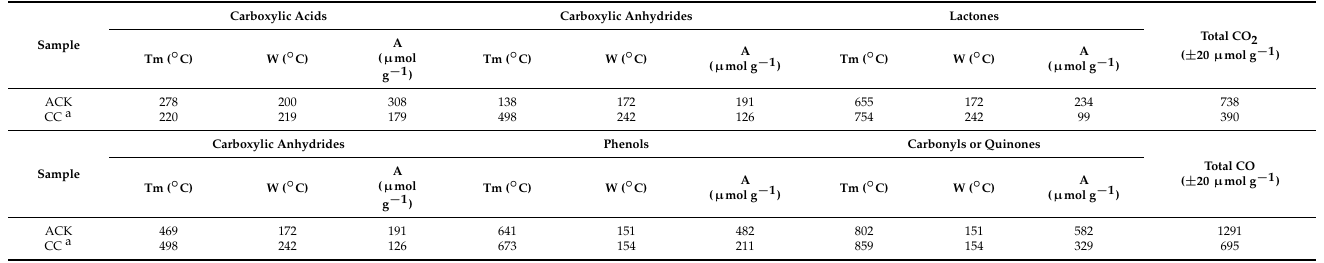
Table 5. Results of the deconvolution of CO 2 and CO spectra using a multiple Gaussian function.